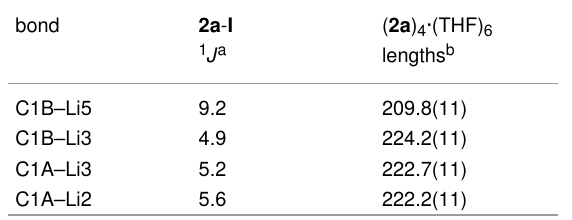
Table 2: 1 J ( 13 C, 6 Li) coupling constants of 2a - I and bond lengths of ( 2a ) 4 ·(THF) 6